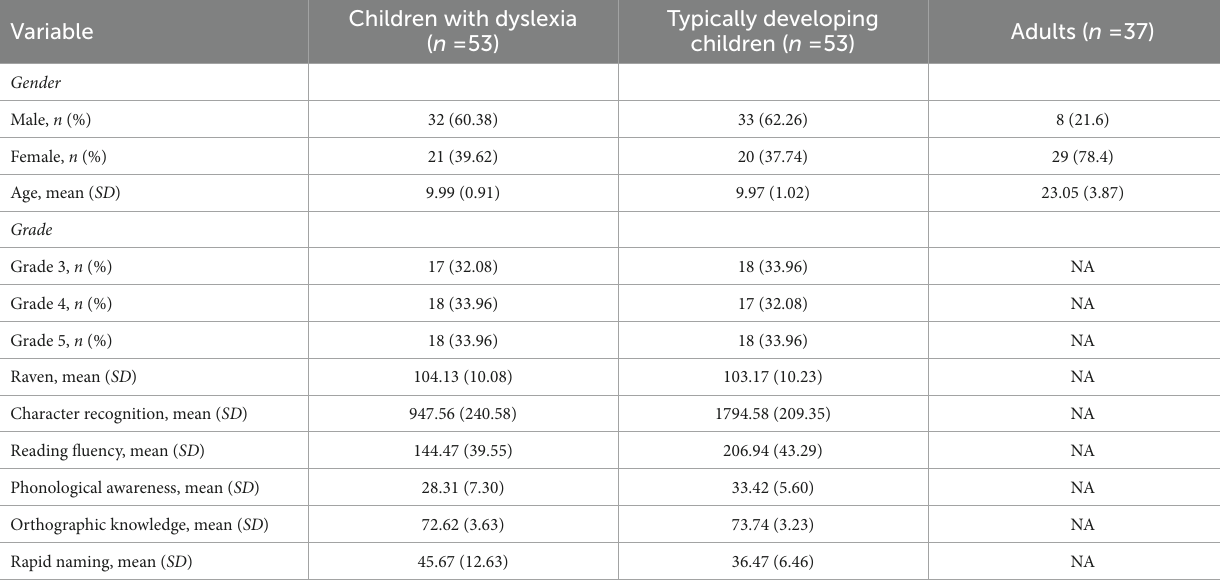
TABLE 1 Participants’ demographic information and test scores for screening.